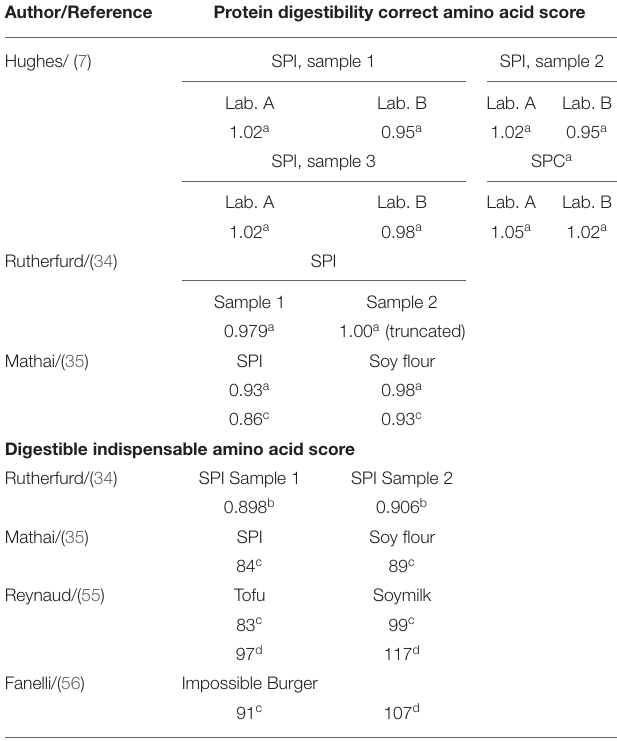
TABLE 2 | Protein quality scores for soy protein derived from different soy products as determined by the PDCAAS and/or the DIAAS using different IAA scoring